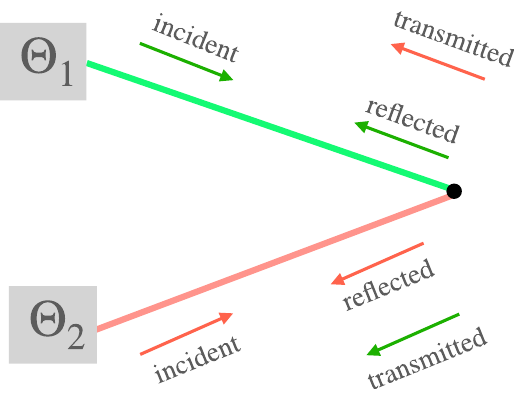
Figure 2 . The energy fluxes given in (3.1). The two half wires are coloured red and green, and space is folded at the interface (black dot). The incoming excitations are thermal while the state of the outgoing ones, consisting of both reflected and transmitted fluids, depends on the nature of the junction as discussed in the main